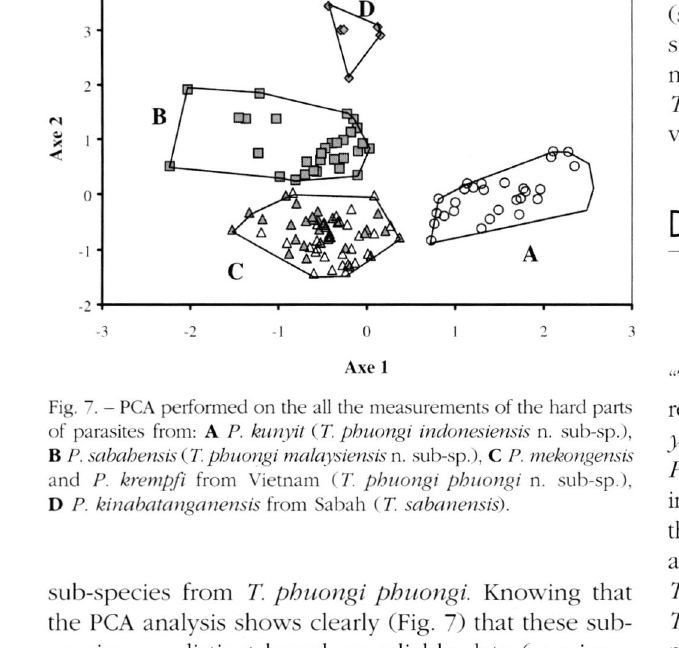
sub-species from T. phuongi phuongi. Knowing